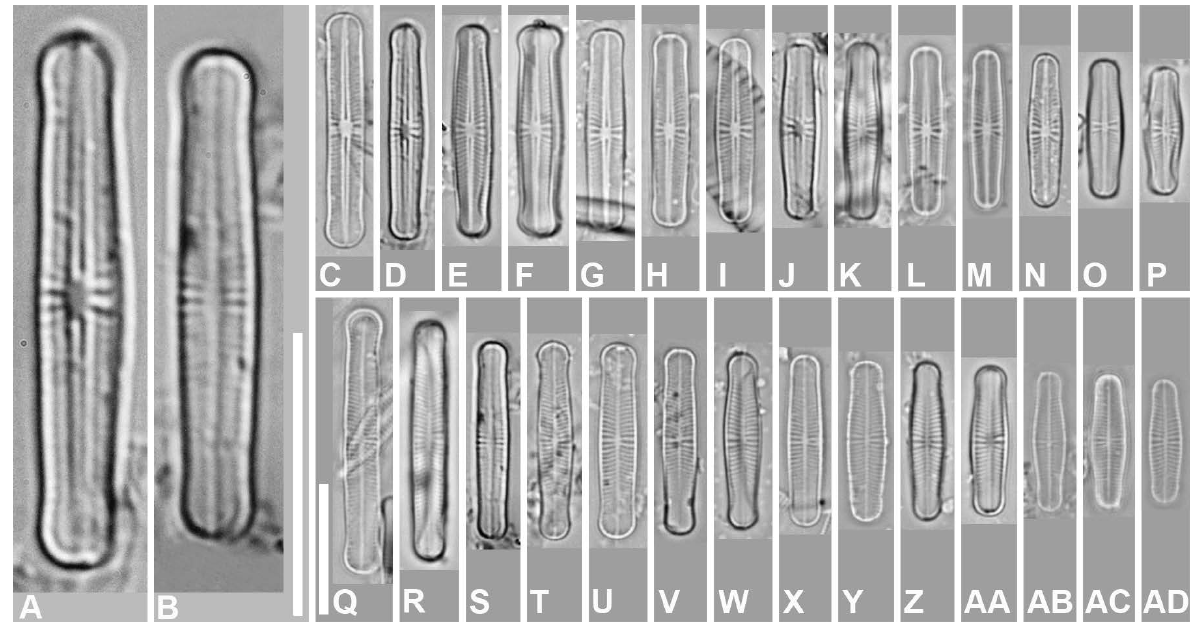
Figure 8. Achnanthidium anatolicum sp. nov., LM micrographs. A , C – P . Views of raphe valves. B , Q – AD . Views of rapheless valves. Scale bar = 10 µm (A, B: 2500×; C–AD: 1000×